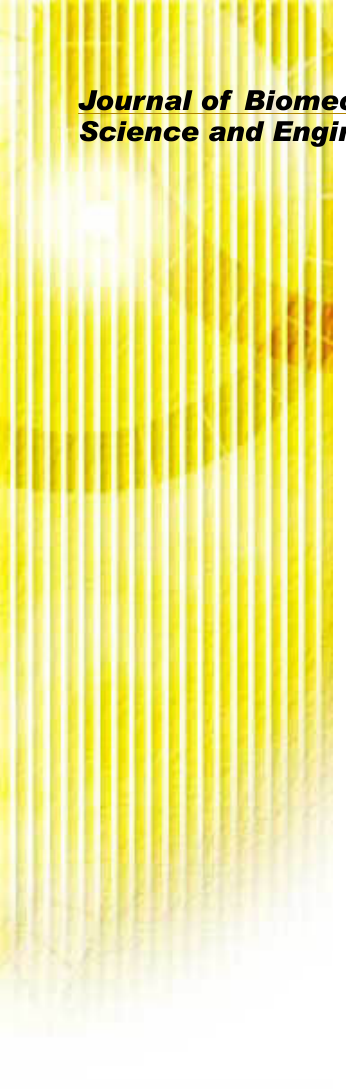
=50 dyne/cm 2 (5.0 Pa). th